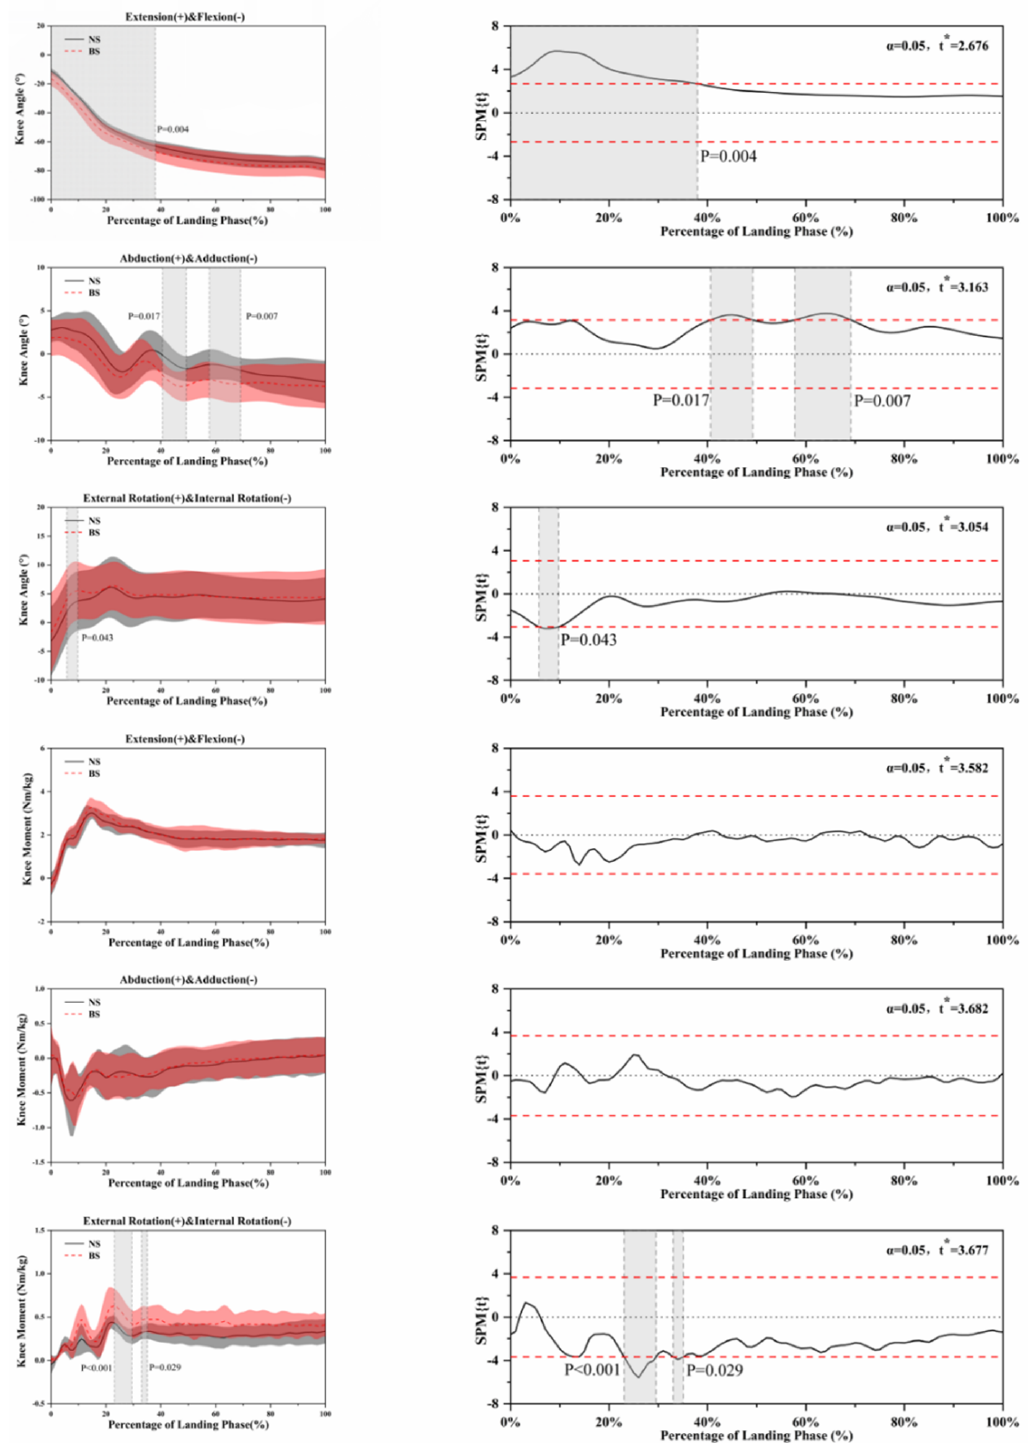
Figure 6. Descriptive results between NS and BS lower-limb statistical parametric mapping results for knee angles and moments during the SLL phase, t -values of the SPM for all participants (post hoc results; dashed red lines represent p = 0.05 level). Grey shaded areas display regions that have statistically significant differences. The scale on the left of each image shows the change in the joint angle and the value of t *. The scale of 0–100 below each image presents an SLL phase.